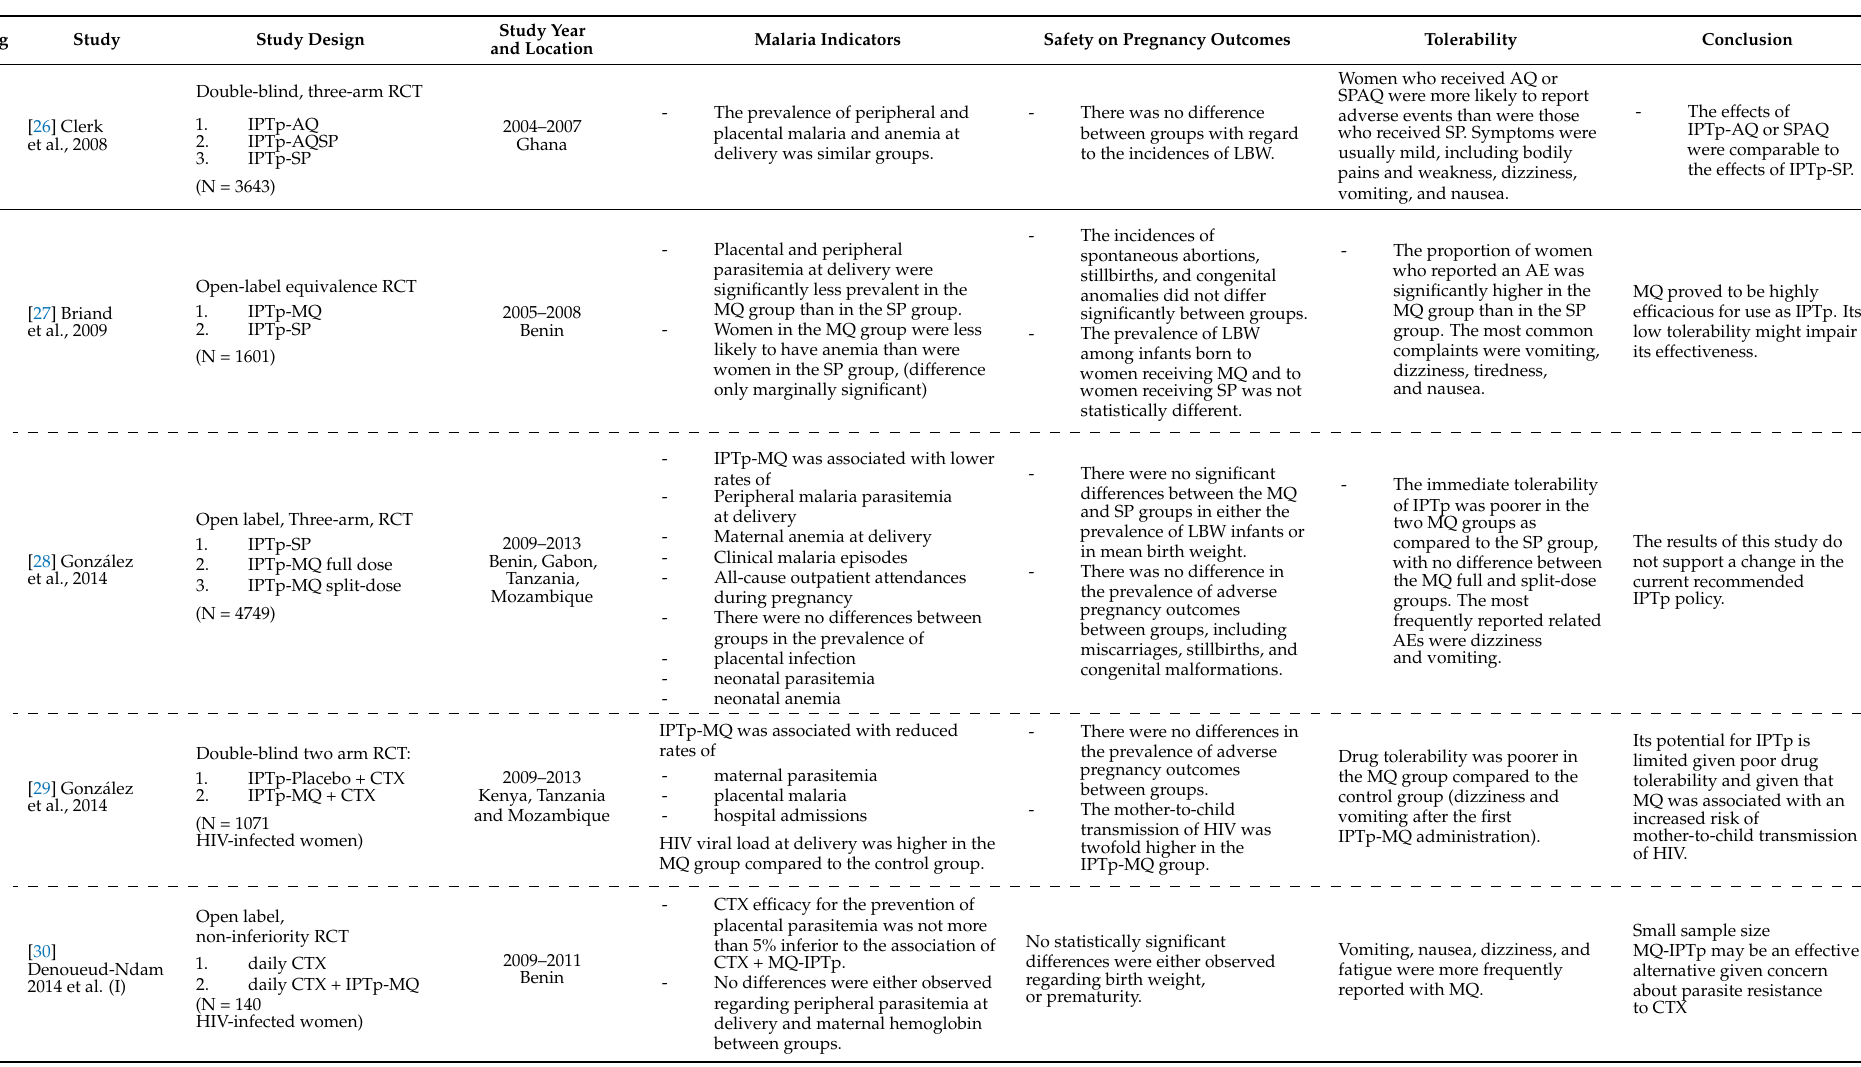
Table 1. Overview of the studies included in this